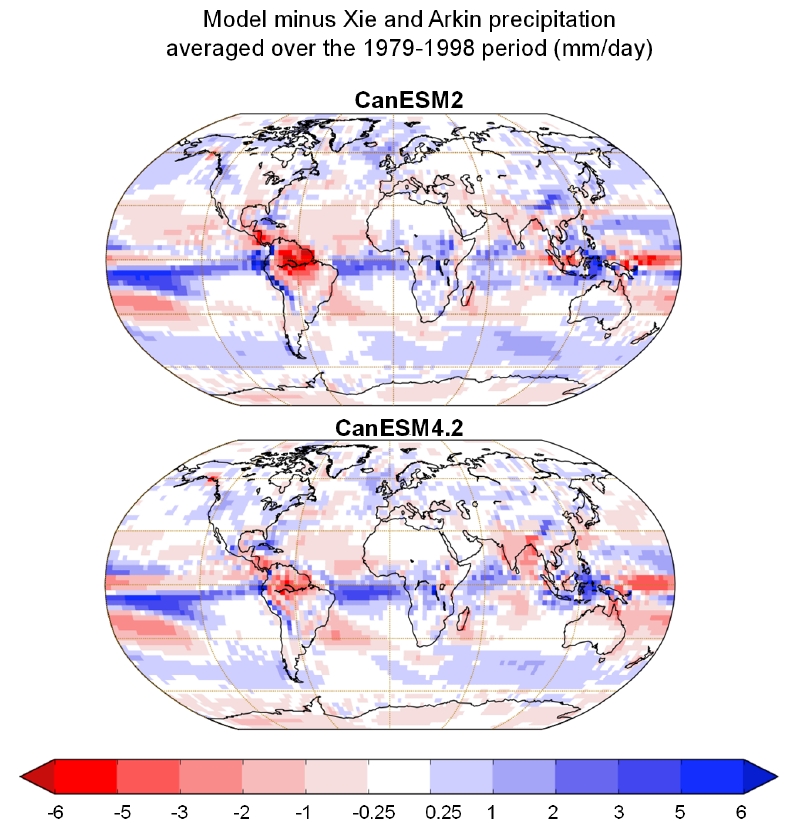
Figure 3. CanESM2 (panel a ) and CanESM4.2 (panel b ; γ d = 0 . 40) precipitation anomalies compared to the observation-based estimates from CPC Merged Analysis of Precipitation (CMAP) based on Xie and Arkin (1997) averaged over the 1979–1998